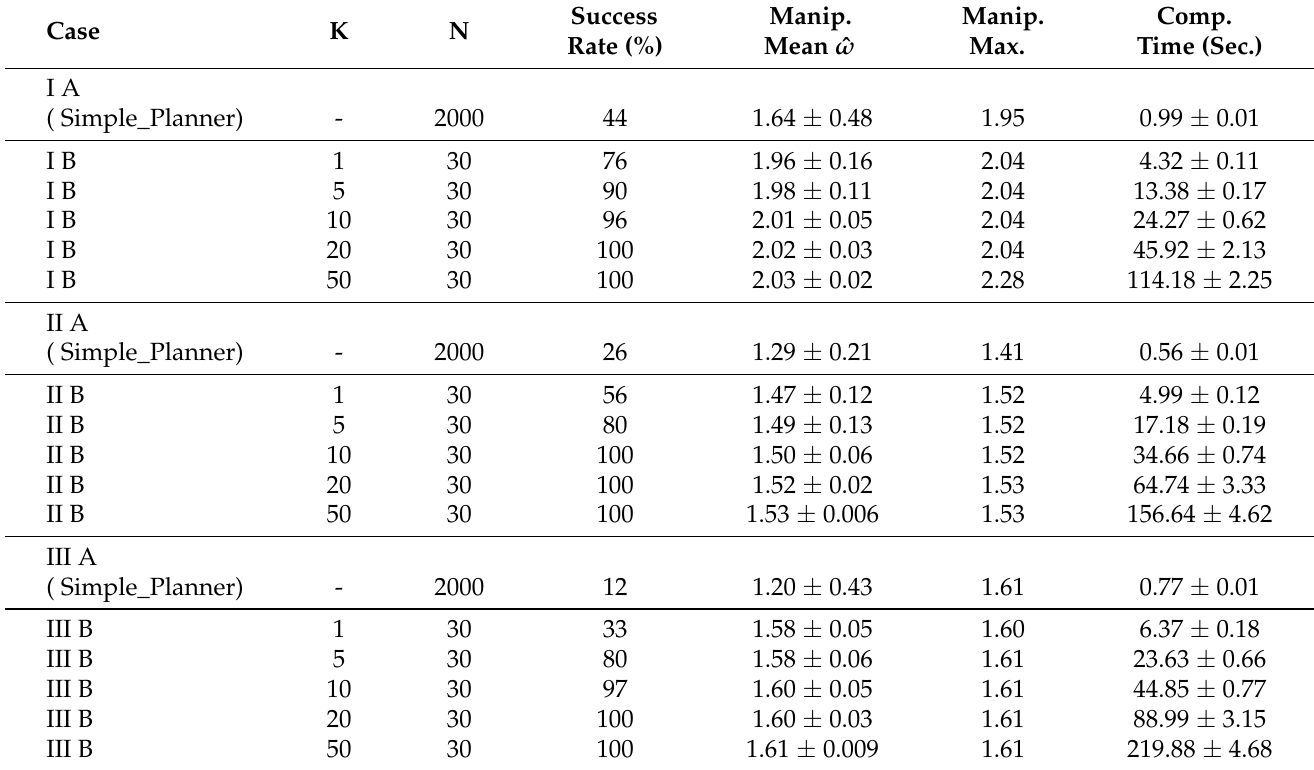
Table 1. Results of case studies I, II and